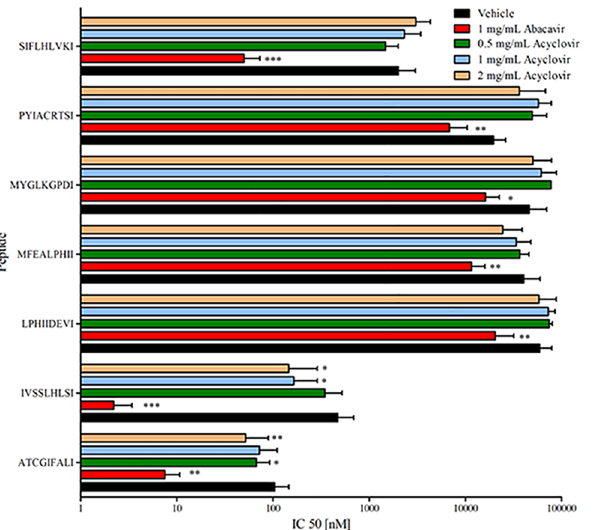
Fig 5. Effects of abacavir and acyclovir on HLA-B * 57:01 binding specificity. Specific peptides with a terminal isoleucine that showed an increased affinity for HLA-B * 57:01 in the presence of abacavir were tested. Values are represented as geometric mean with 95% CI of two independent runs in triplicates, analyzed for statistical significance by Mann-Whitney U test comparing log IC 50 values vs. vehicle; p < 0.05 was considered significant ( * p < 0.05; ** p < 0.01; *** p < 0.001).